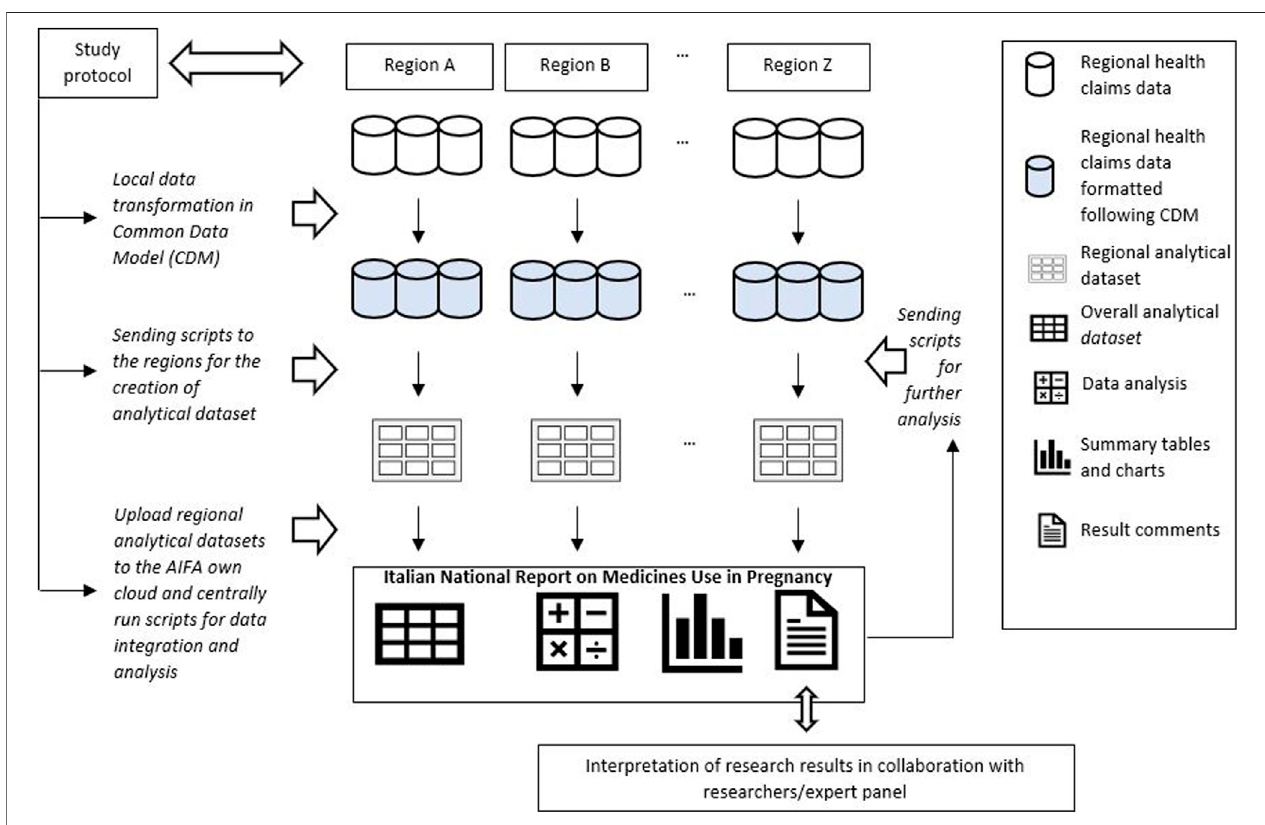
FIGURE 1 | Analytical approach used to execute observational studies within the network MoM-Net.